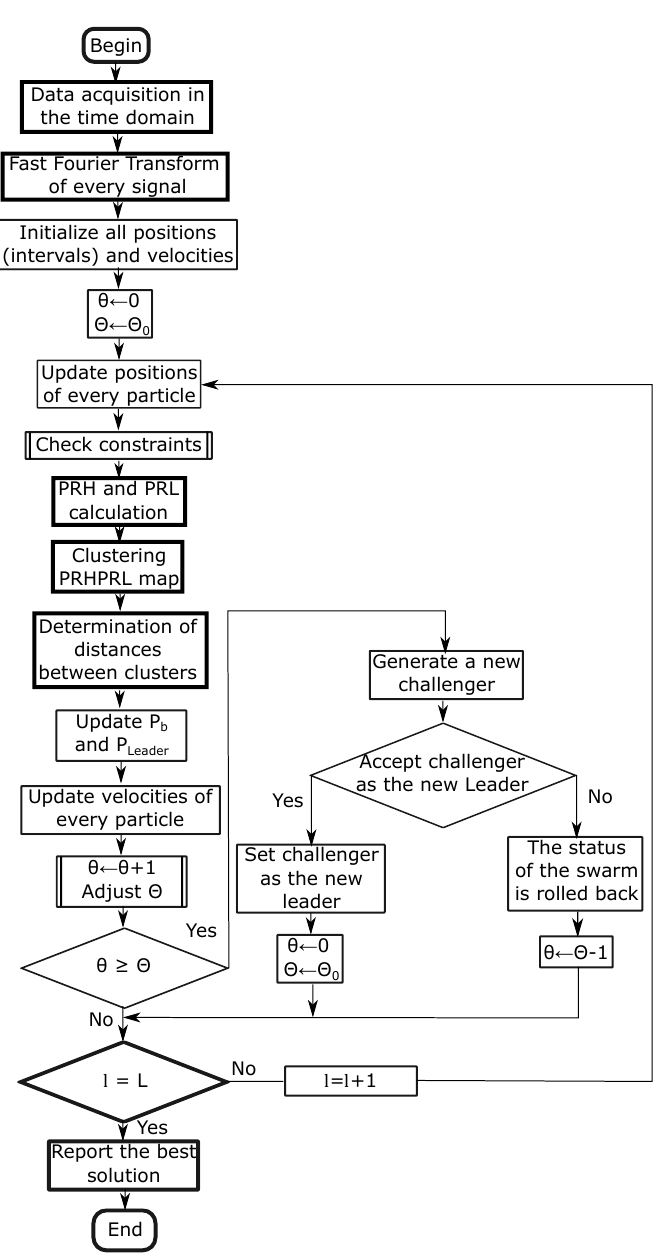
Figure 2. Flow diagram of the particle swarm optimization with aging leader and